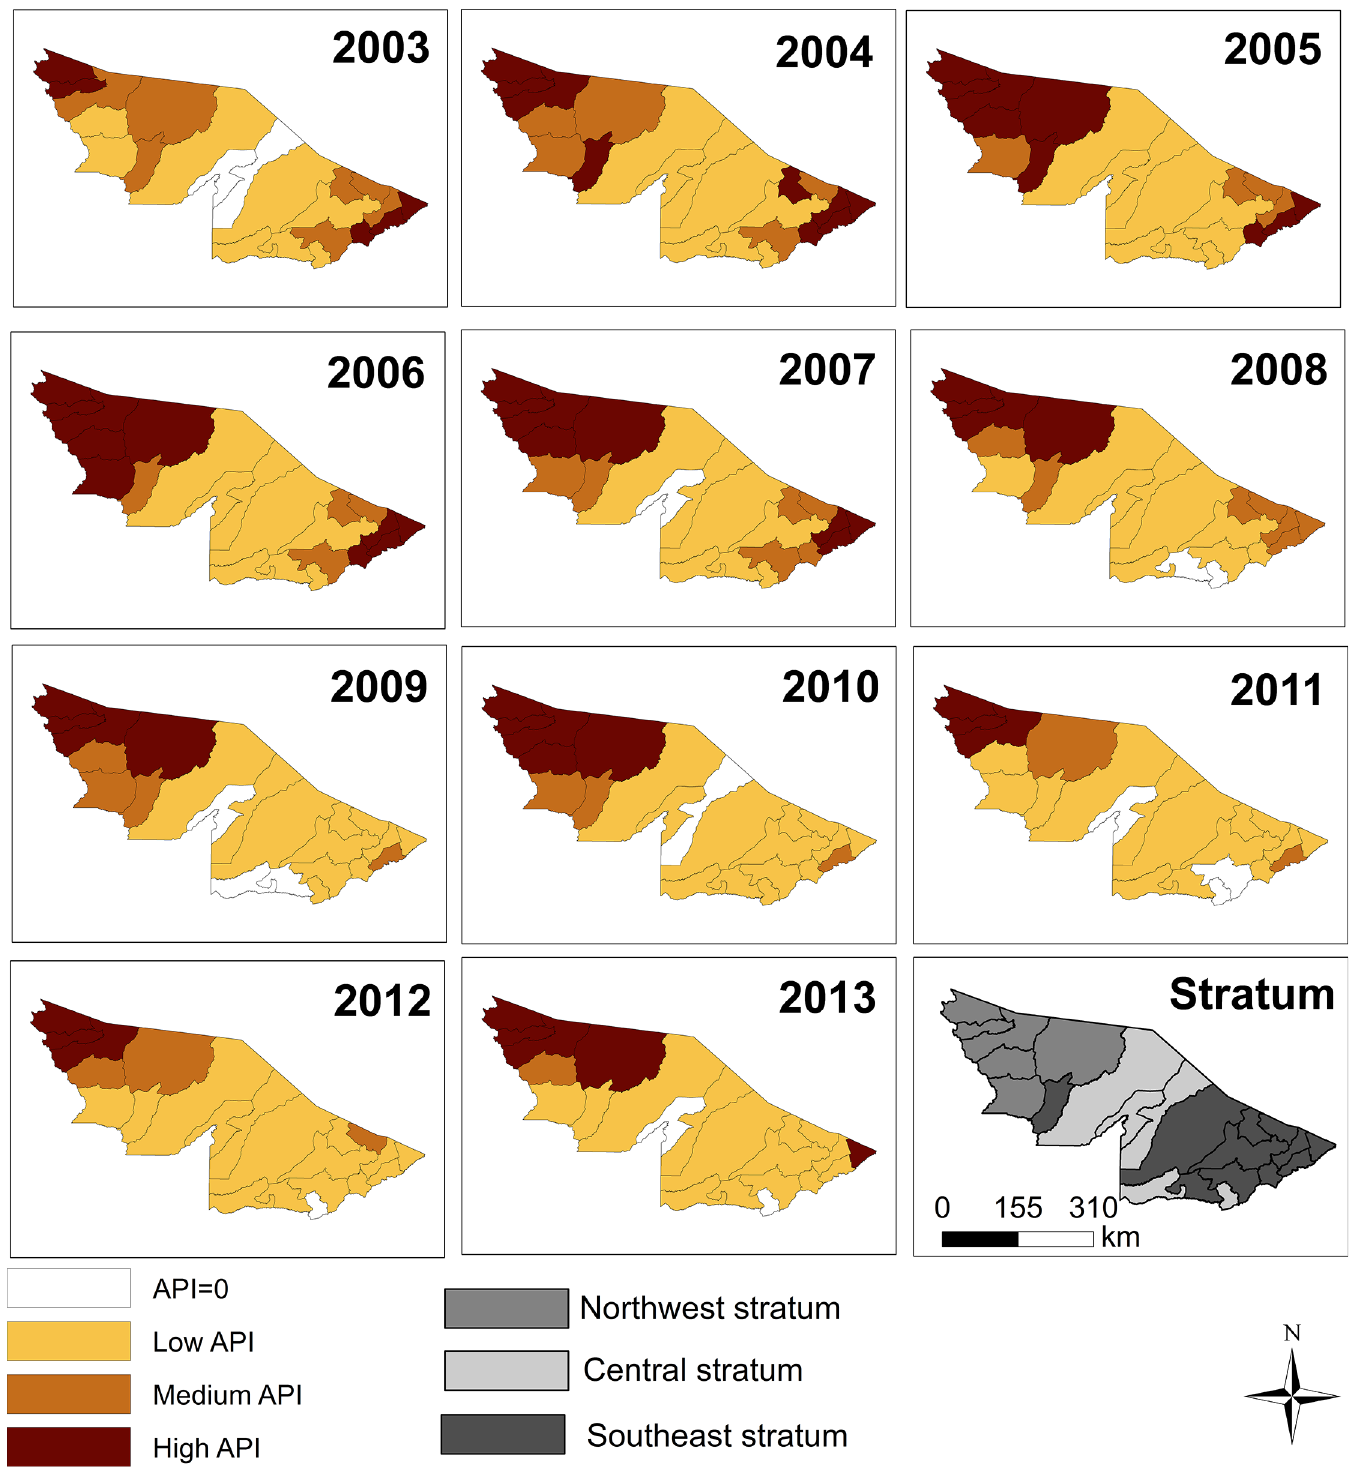
Fig 4. Distribution of Annual Parasitic Index by county in Acre State, from 2003 to 2013. API = 0: No risk; Low API: < 10 cases; medium API: (cid:1) 10 and < 50 cases; high API: (cid:1) 50 cases.